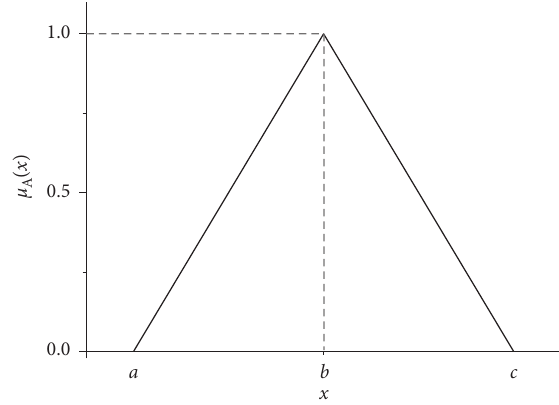
Figure 1: Triangular fuzzy number ( a , b , c ).